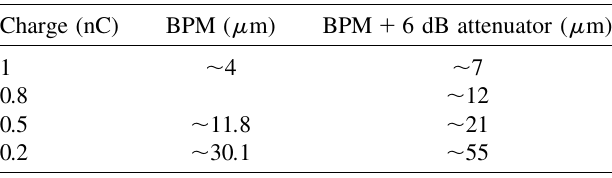
TABLE III. Resolution of the reentrant BPM.